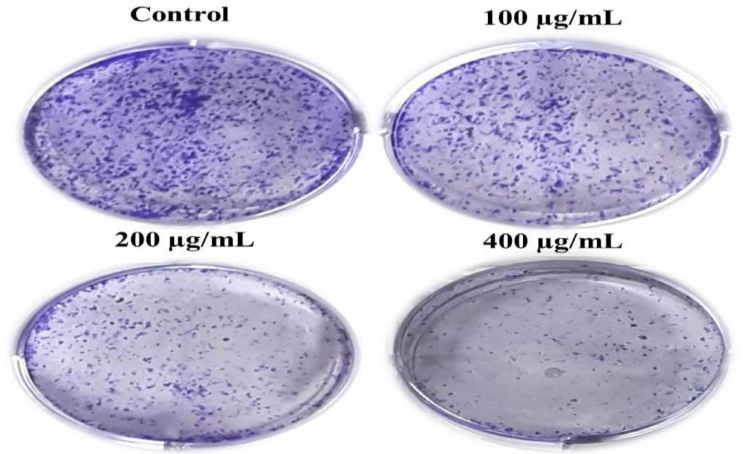
Figure 3. AvL -EtOH treatment resulted in the loss of clonogenic potential in NSCLC A549 cells. Representative images demonstrated the effect of AvL -EtOH on the loss of colony formation in A549 cells post AvL